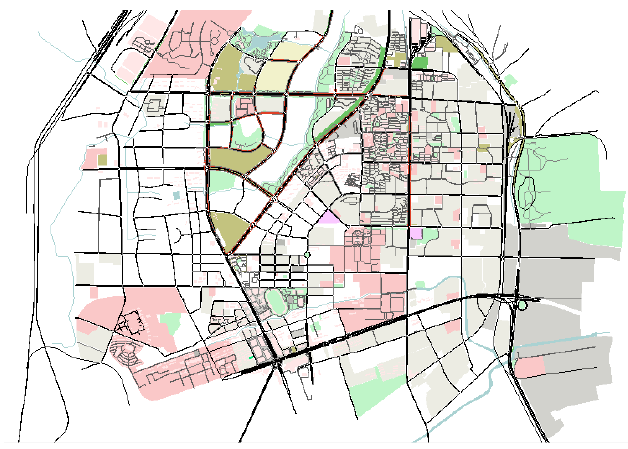
Figure 6. Map of the simulation calculation.